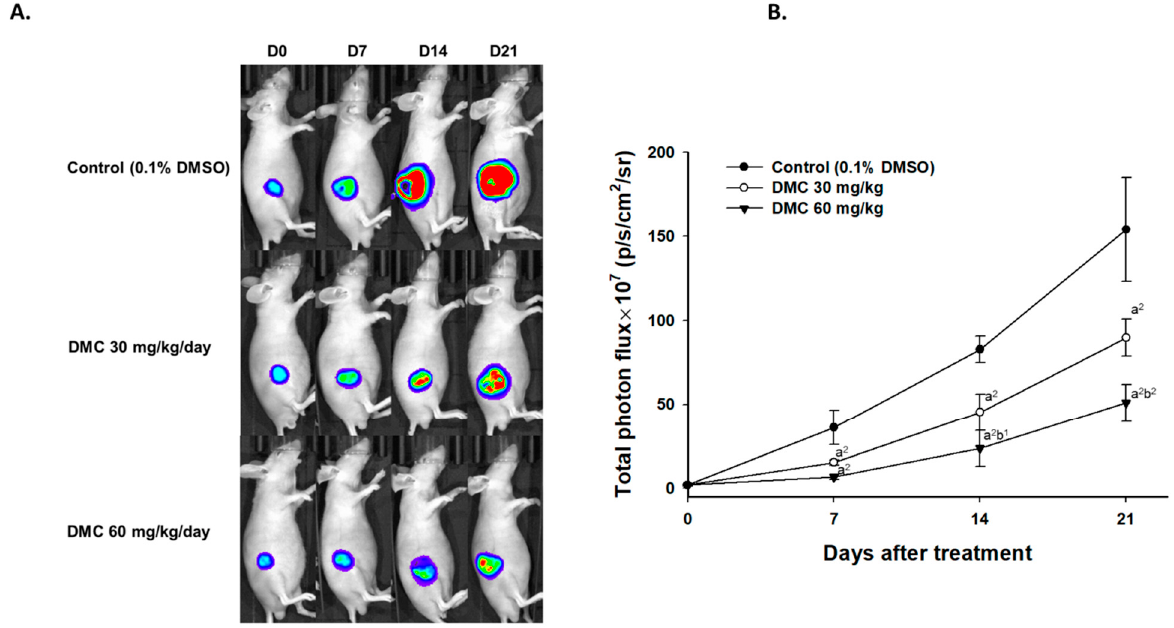
Figure 2. Luc2 signals from living tumor cells were suppressed by DMC treatment. ( A ) The representative BLI results from each group at different time points. ( B ) Quantification results of luc2 signal intensity of tumors. (a 2 < 0.01 vs. control; b 1 p < 0.05 and b 2 p < 0.01 vs. DMC 30 mg/kg).